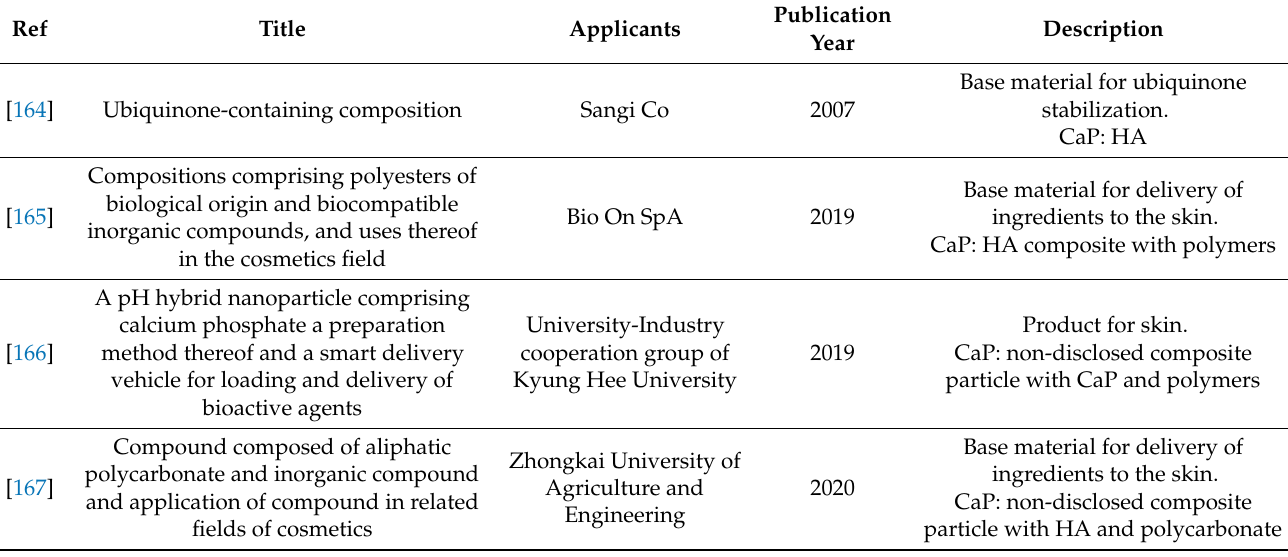
Table 2. List of patents about calcium phosphates used to aid the delivery of biomolecules to